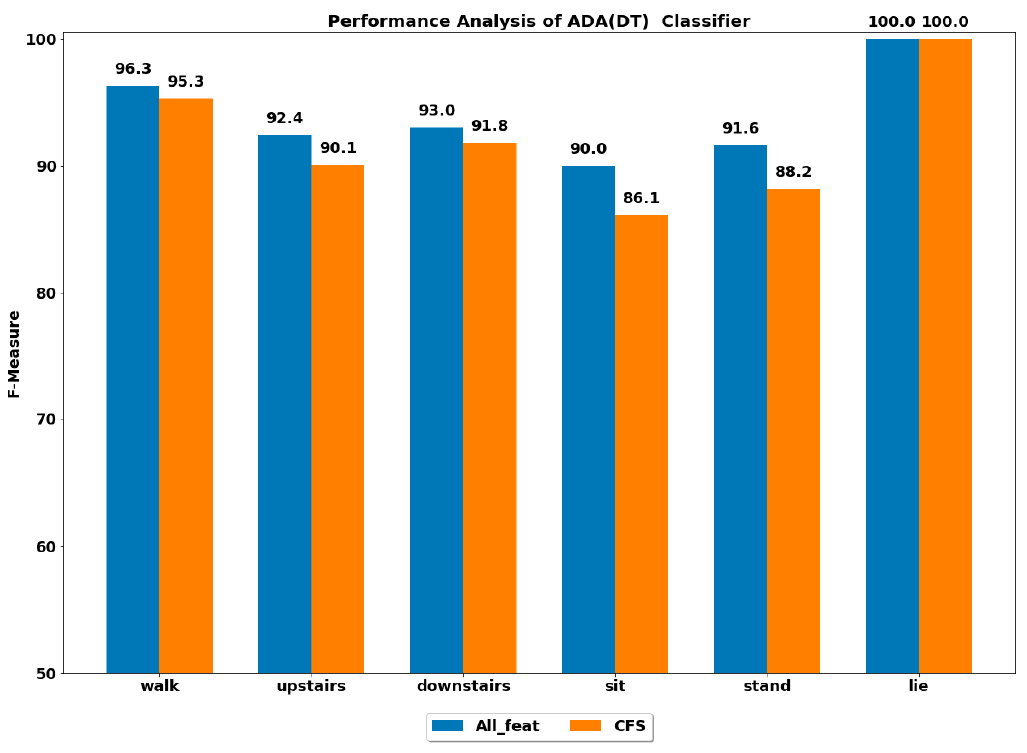
Figure 6. Performance analysis of CB (cat boosting) classifier with and without feature selection to classify set of ADLs.